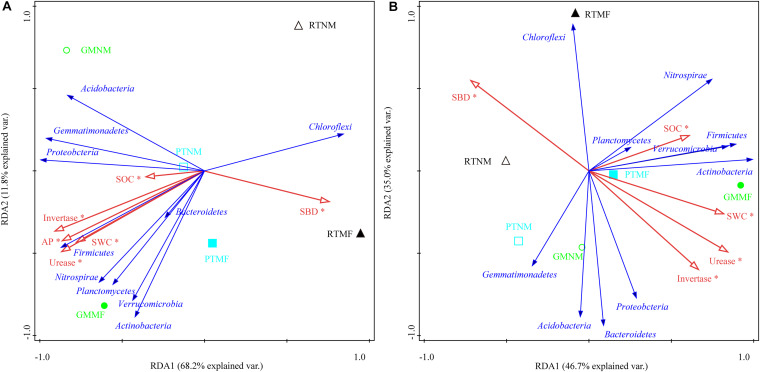
Ordination plots of the results from the redundancy analysis used to explore the relationships between microbial community (blue arrows) and soil physicochemical properties (red arrows) in 0–10 cm (A) and 10–20 cm (B) soil layers from treatments. SOC, soil organic carbon; soil water content, SWC; SBD, soil bulk density; SP, soil porosity; AN, available N content; AP, available P; AK, available K content; Urease, soil urease activity; Invertase, soil invertase activity; Catalase, soil catalase activity. RT, reduced tillage (triangle), PT, plow tillage (square), GM, green manure (circle). Solid and hollow represent with mulching film (MF) or without MF (NM). *Correlations are significant at P < 0.05.